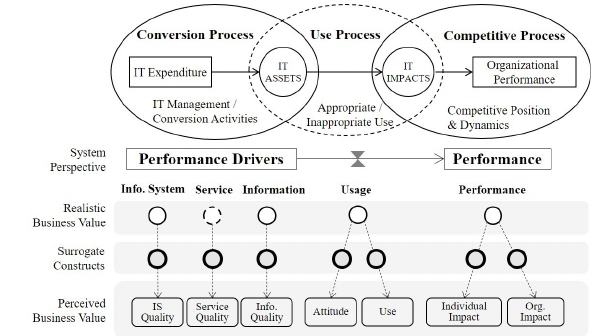
Figure 8. IS Evaluation Concepts and Measure